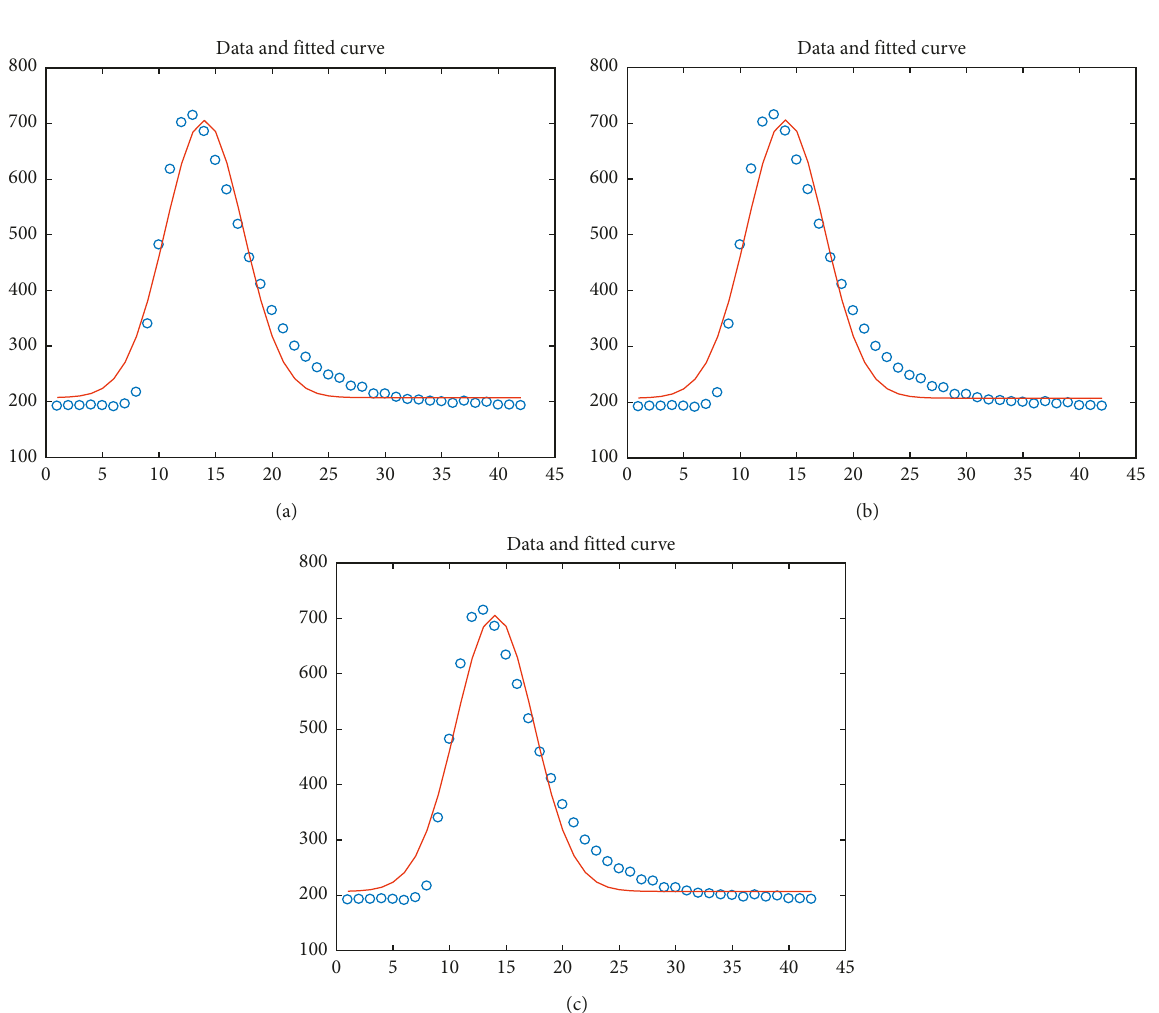
Figure 3: Waveform data and fitting curves. (a) VP